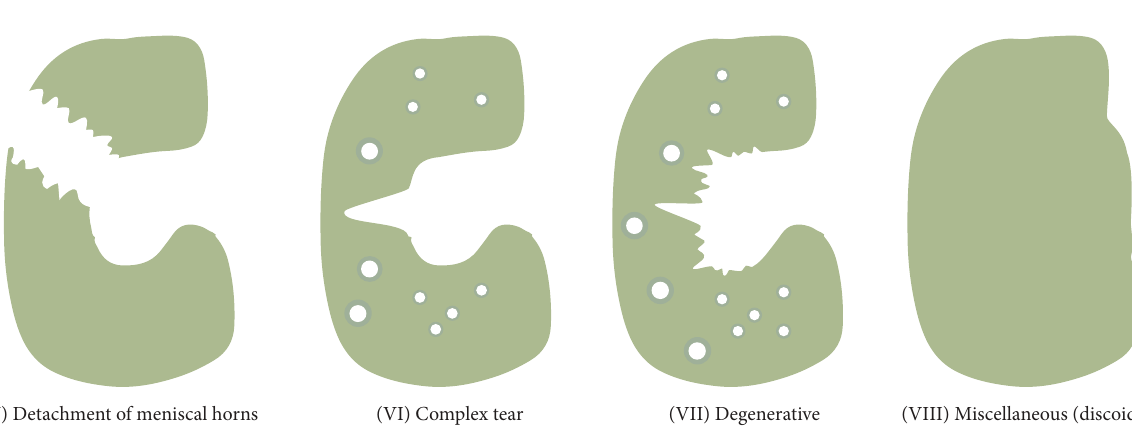
Figure 5: Schematic diagram of the eight different types of meniscal lesions according to Casscells